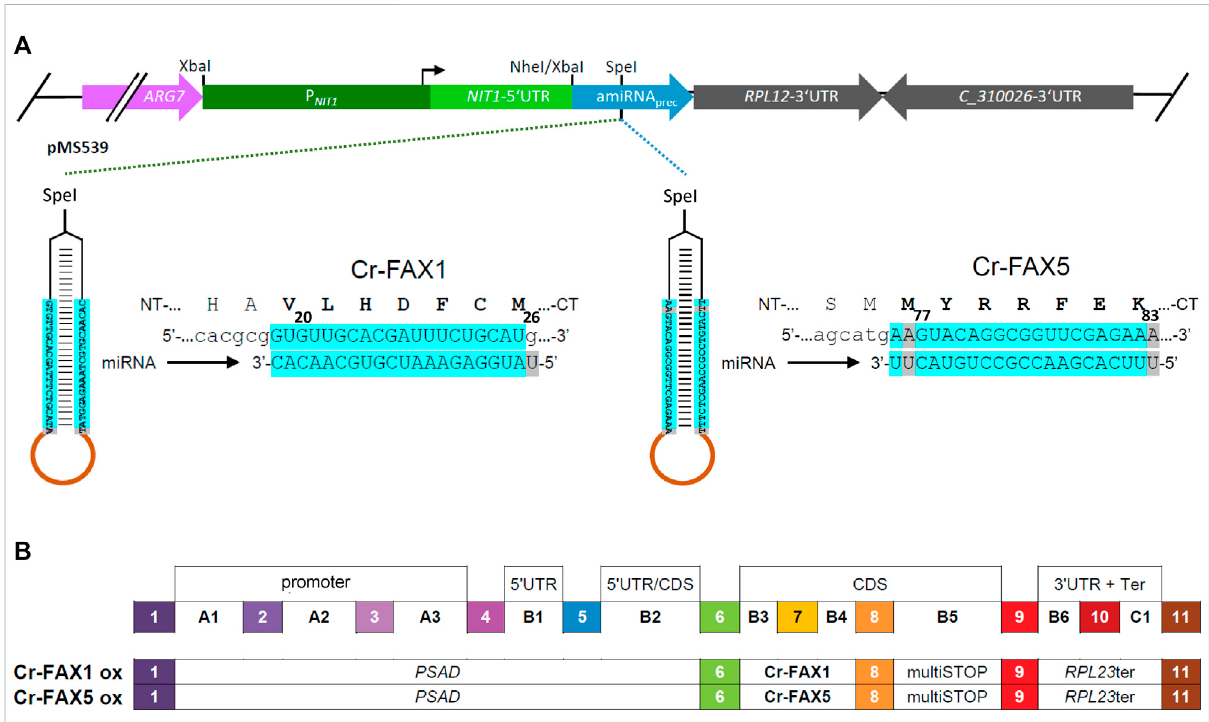
FIGURE 1 Knockdown and overexpression constructs for Cr-FAX1 and Cr-FAX5 genes. (A) Schematic drawing of arti fi cial microRNA (amiRNA) constructs for knockdown of Cr-FAX1 and Cr-FAX5. The amiRNAs directed against Chlamydomonas Cr-FAX1 (left) and Cr-FAX5 genes (right) are SpeI - subcloned into the pMS539 plasmid vector (top), which harbors the inducible NIT1 (nitrate reductase 1) promoter (for details see Schmollinger et al., 2010). The amiRNA generated by pMS539 targets regions in the second exons of Cr-FAX1 (left) and Cr-FAX5 (right), coding for amino acids 20 – 26 of mature Cr-FAX1 and 77 – 83of Cr-FAX5, respectively.Base-pairing nucleotides of theamiRNA and Cr-FAX1 , Cr-FAX5 mRNAs are shaded in turquoise. (B) Schematic drawing of level 1 constructs according to the MoClo syntax (Patron et al., 2015; Crozet et al., 2018) for overexpression of Cr-FAX1 and Cr-FAX5